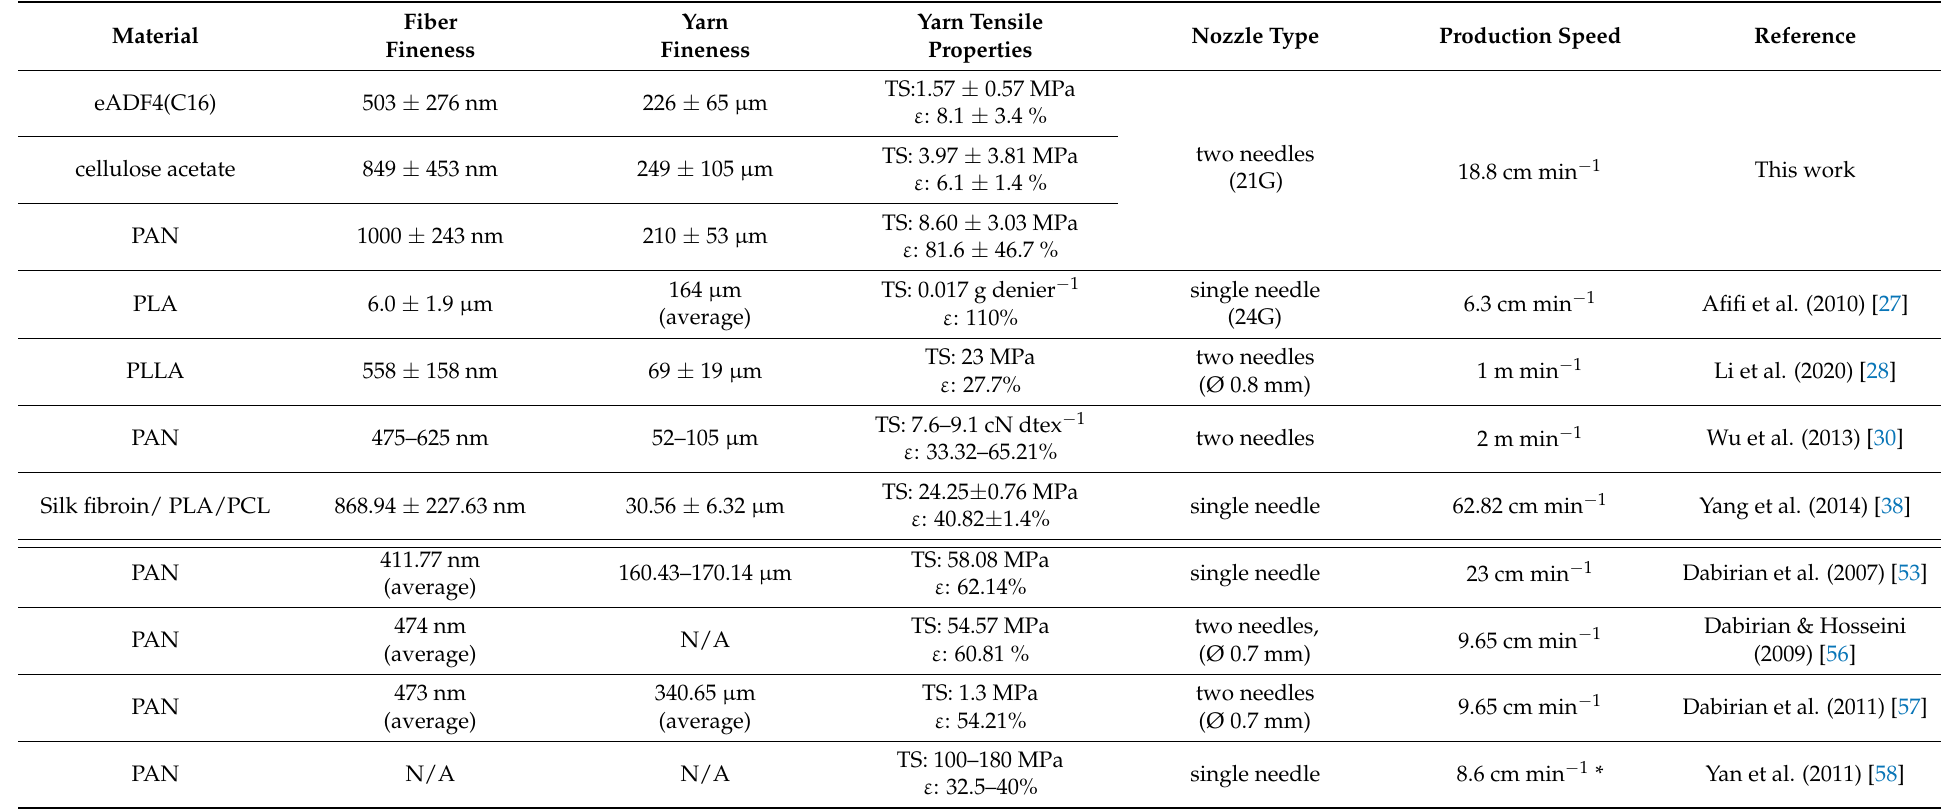
Table 1. List of materials electrospun into yarns, along with fiber and yarn fineness, yarn tensile properties, nozzle type and production speed of continuous yarn electrospinning. Our data and data from the four exemplary works discussed in the previous sections are listed above the double lines, while additional data from the literature are listed below. TS: tensile strength, ε : elongation at break, N/A: not available, PAN: polyacrylonitrile, P(AN-co-MA):